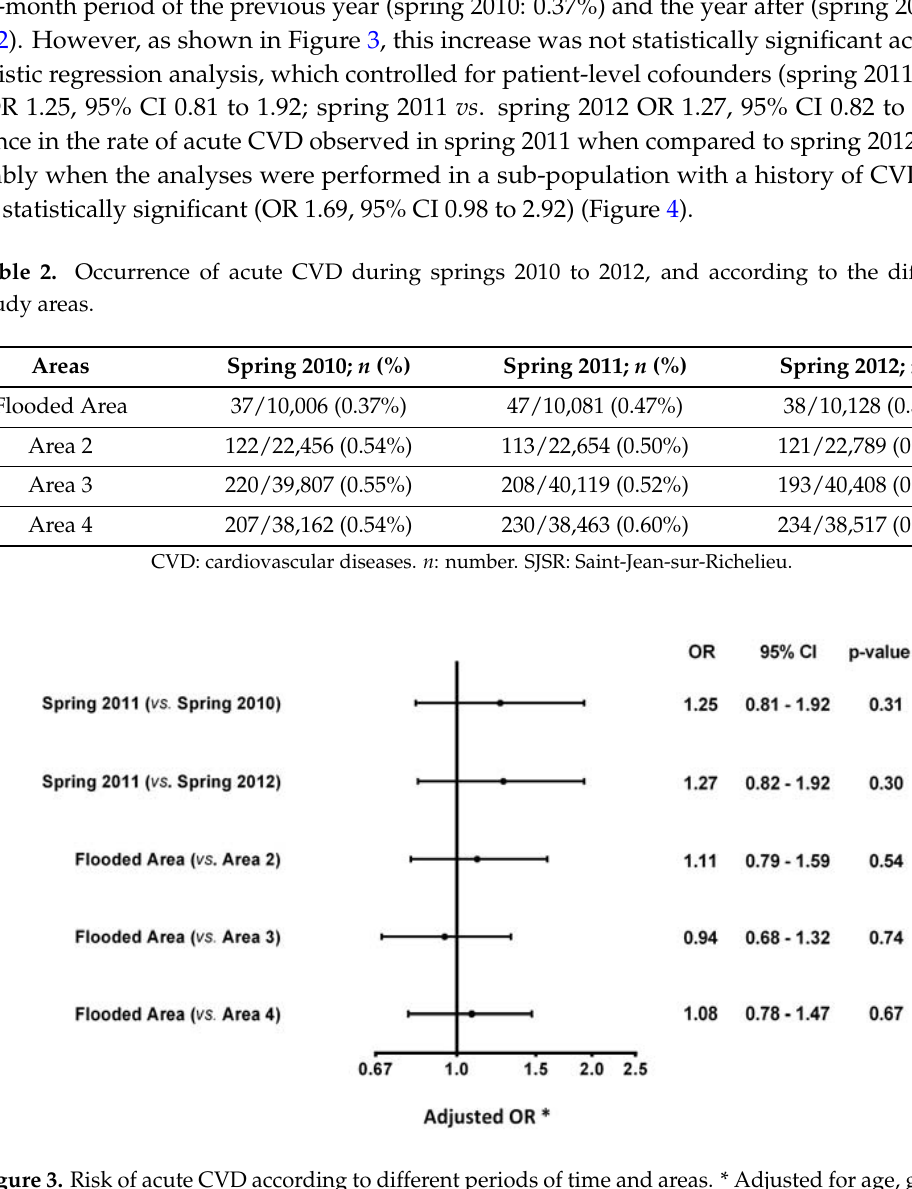
Figure 4. Risk of acute CVD among individuals with a medical history of CVD. * Adjusted for age, gender, Charlson comorbidity index, diabetes, hypertension, and mental health disorders. CI: confidence intervals, OR: odds ratio.